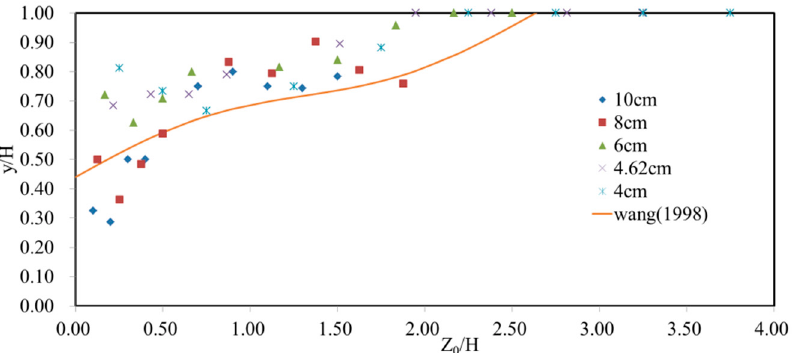
Figure 8. Computed dip position compared with the experimental data.